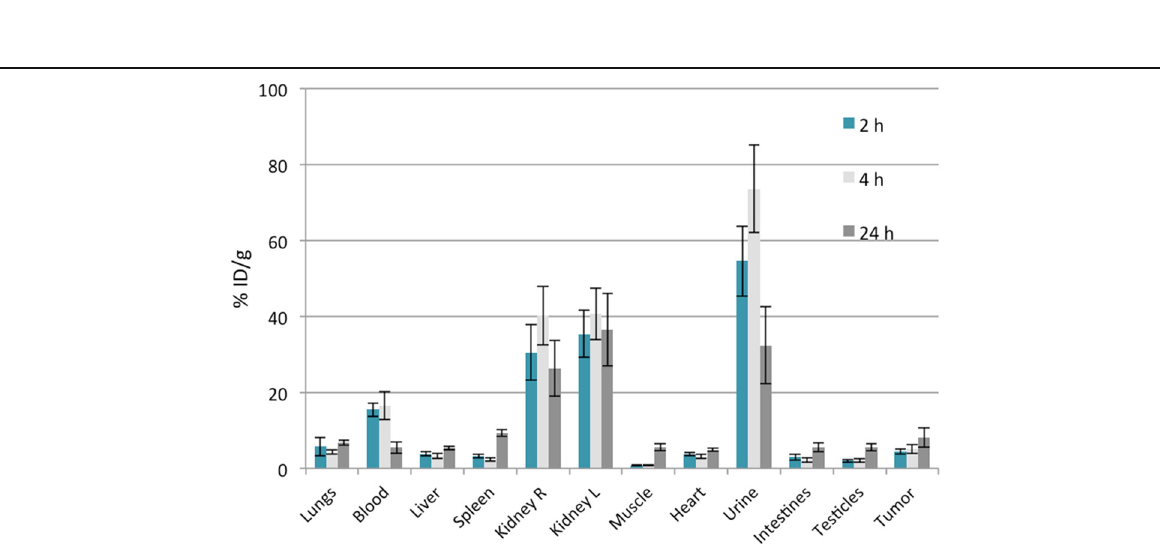
Fig. 9 Ex vivo biodistribution of [ 44 Sc]Sc-DOTA-HPMA 31c in tumor-bearing mice ( n = 5 for each time